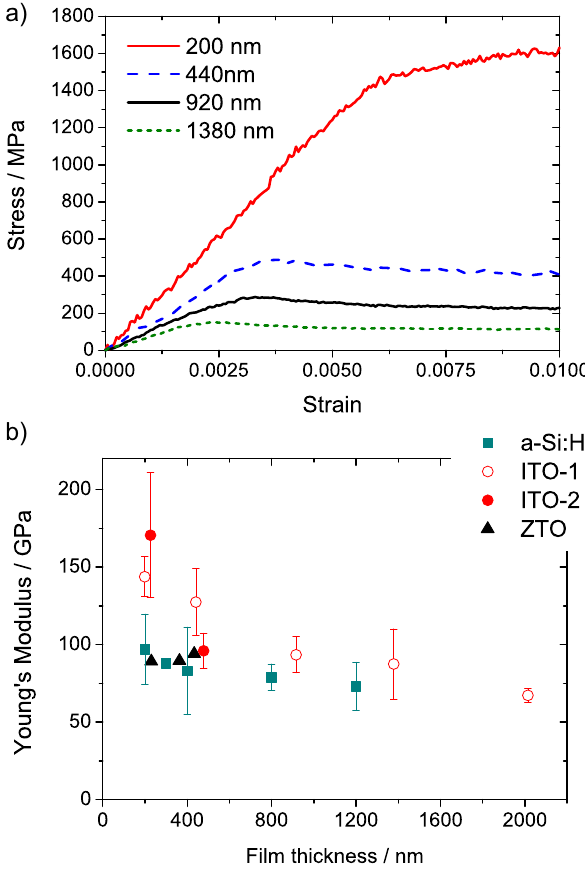
Figure 4. ( a ) Characteristic stress–strain curves for ITO-1 films of varying thickness after subtracting the substrate contribution. For comparison, the initial strain due to prestraining was shifted to zero. Stresses beyond the linear region at small strains do not correspond to the applied stress in the coating due to film rupture; ( b ) Young’s moduli that were extracted from the initial slope of stress–strain curves. Error bars indicate the standard deviation for averaged values in the case of several